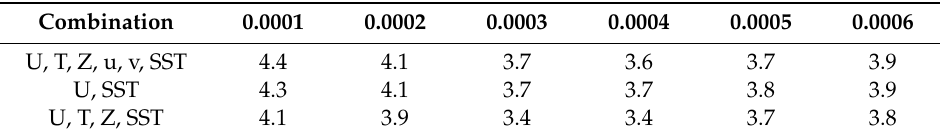
Table 2. Mean absolute errors (MAEs) (m / s) of the models trained on the three combinations of variables at di ff erent learning rates.